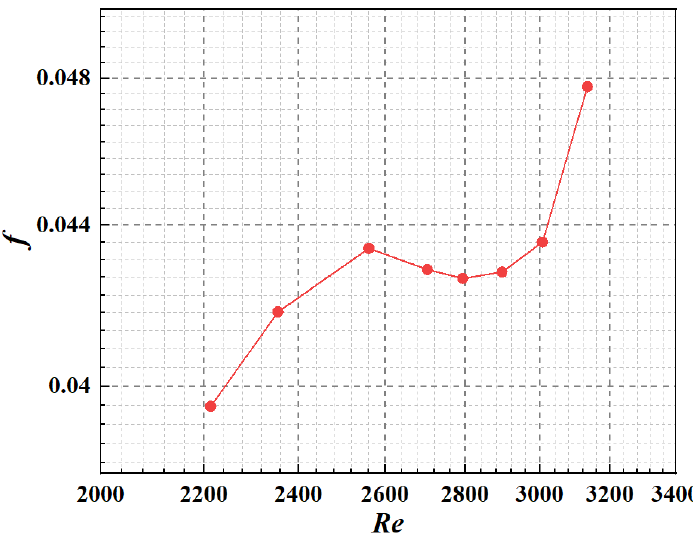
Figure 8. Variation in the friction factor with the Reynolds number.